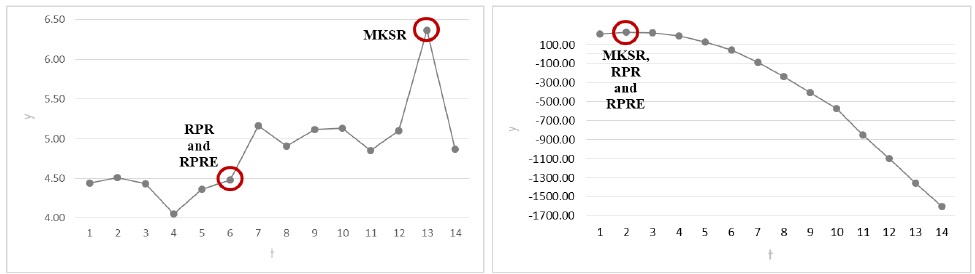
Figure 9. Graphs with paths from both cases comparing the three